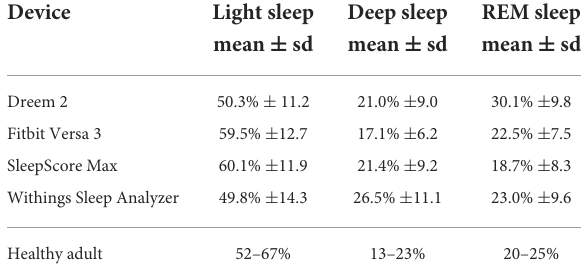
TABLE 5 The mean share of sleep stages of total sleep time as percentages, standard deviation in